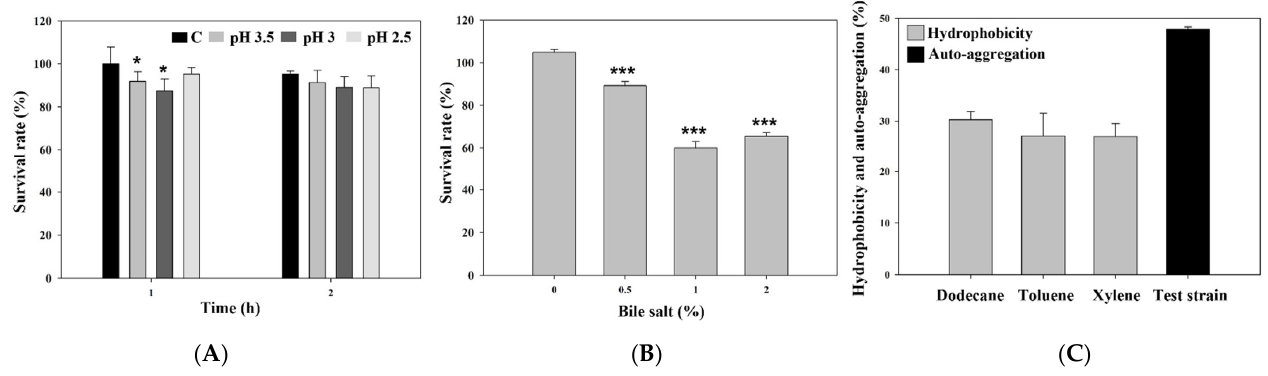
Figure 1. Acid tolerance ( A ), bile salt tolerance ( B ), and hydrophobicity and auto aggregation ( C ) of P. konkukensis . * p < 0.05 and *** p < 0.001.